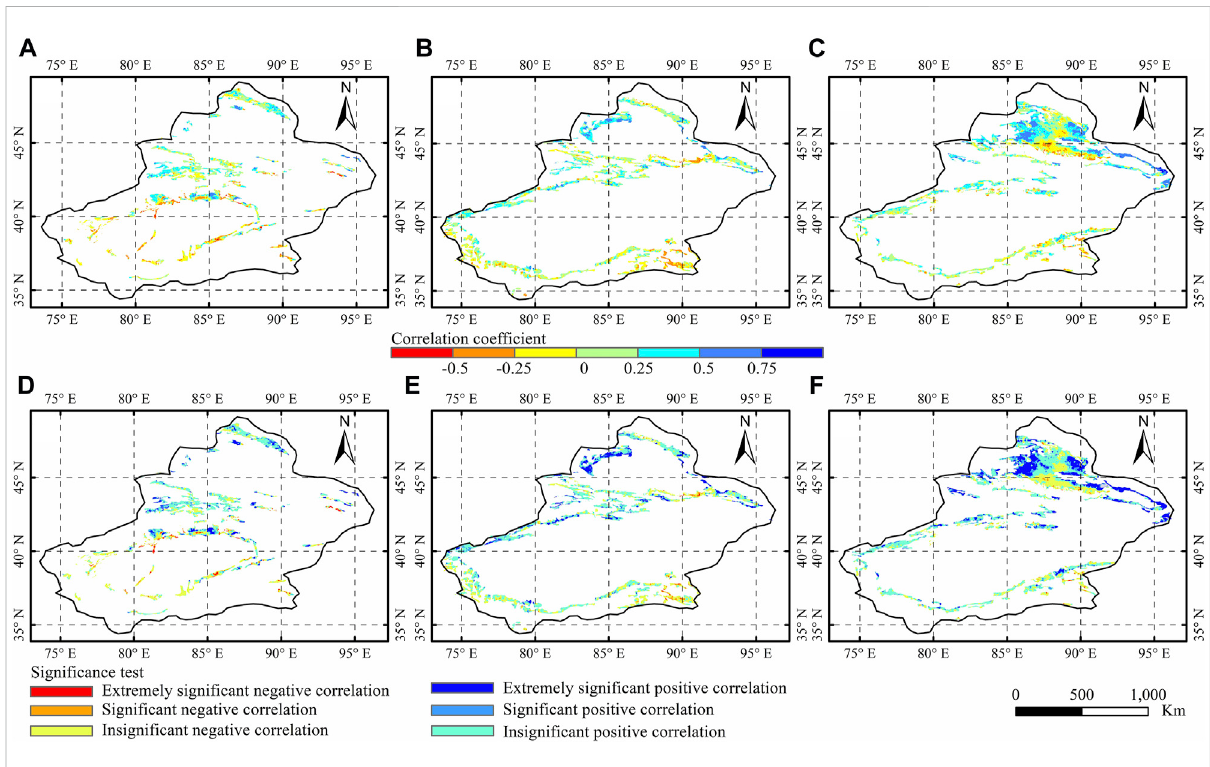
FIGURE 6 Correlation coef fi cient and signi fi cance test between the NDVI and SPEI-12 of meadow, steppe, and desert grassland in Xinjiang. (The correlation coef fi cient between the NDVI and SPEI-12 of meadow (A) , steppe (B) , and desert grassland (C) in Xinjiang and the signi fi cance test between the NDVI and SPEI-12 of meadow (D) , steppe (E) , and desert grassland (F) in